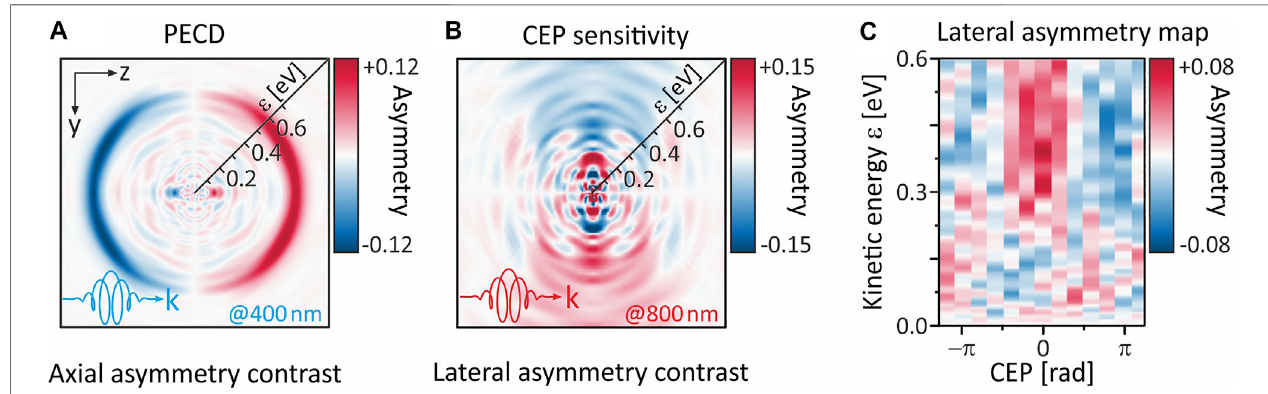
FIGURE 11 | PECD and lateral photoelectron asymmetries in the MPI of (-)-fenchone molecules using circularly polarized femtosecond laser pulses. (A) PECD observed at 400 nm. (B) Previously unpublished results on lateral asymmetries in the photoelectron emission using LCP few-cycle pulses with a duration of Δ t ≈ 5 fs centred at λ 0 (cid:2) 800 nm. (C) CEP-dependence of the lateral asymmetry displayed as an energy-resolved asymmetry map.